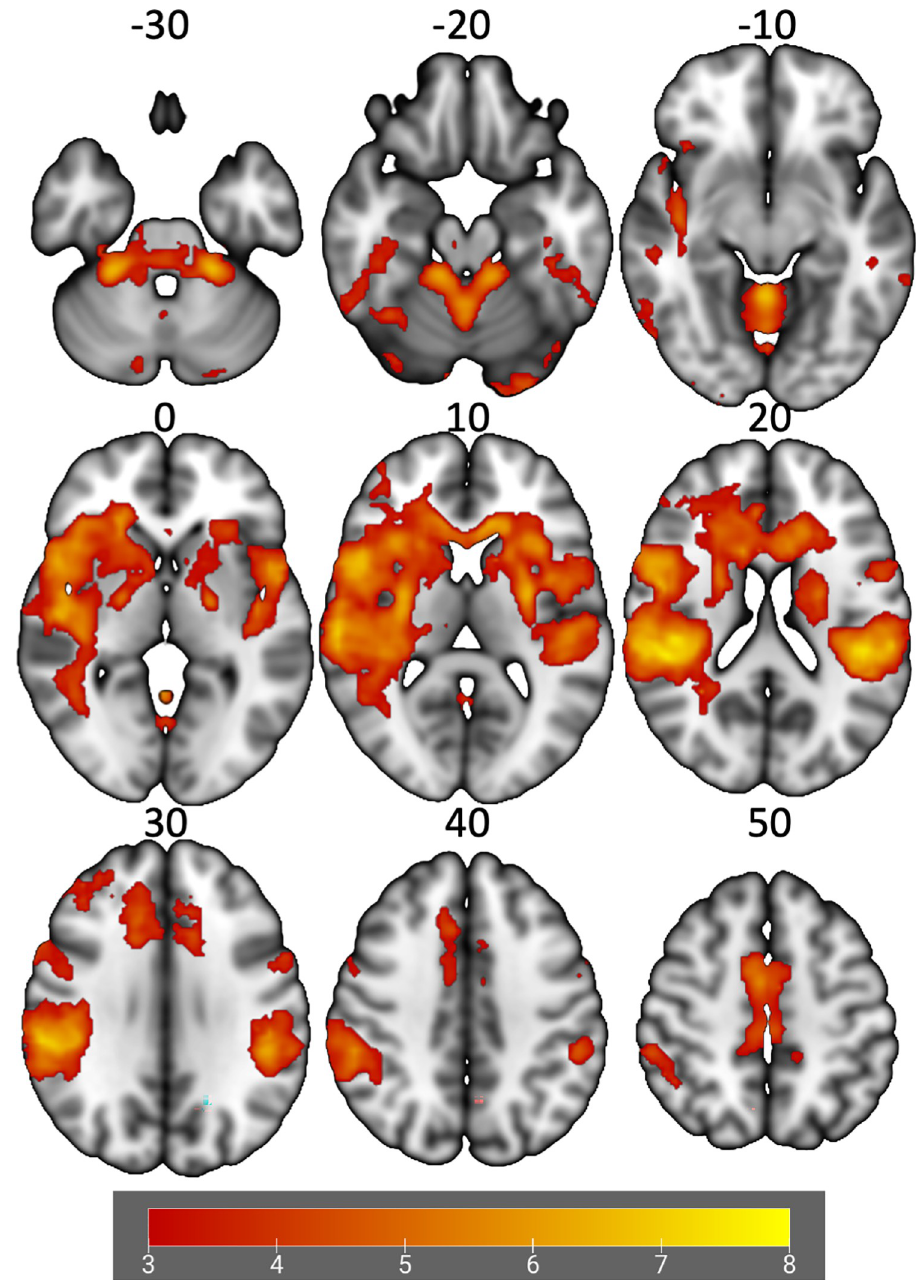
Fig 2. Group average areas of increased activation during the bilateral leg press fMRI paradigm (z-statistic images with a cluster threshold of z > 3.1 and p < .05 corrected). Numbers on top of each axial slice indicate the z- coordinate in MNI space and the bar on bottom reflects the z-statistic color